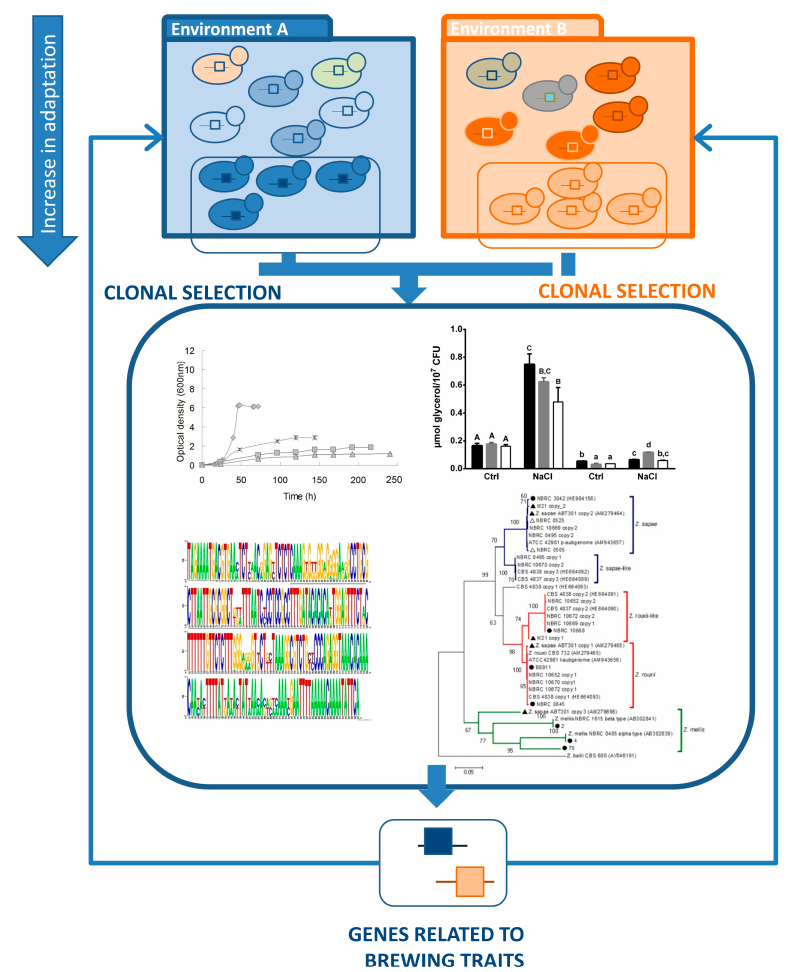
Figure 3. Marker-assisted selection of natural variants harboring brewing relevant traits. Clonal selection provides the best adapted candidates for brewing, while genomics and phenomics outline the map of loci responsible for brewing characteristics. This information, in turn, can be used to improve the selection of novel powerful and costumed-designed candidates. Letters on the columns represent statistical